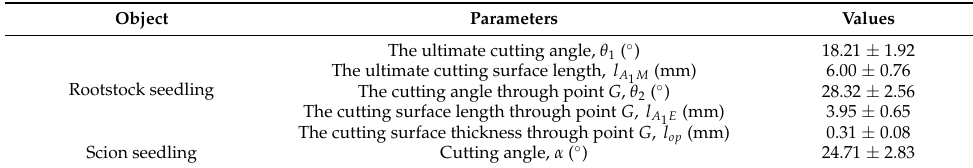
Table 3. Ultimate cutting parameters of the rootstock.